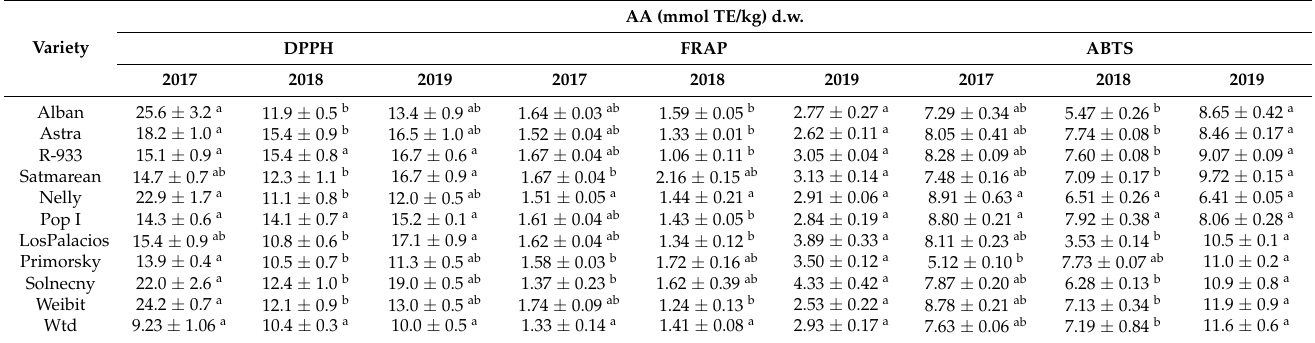
The values represent the means of four repetitions ± standard deviation. Small letters (a, b) show statisti- cally significant differences ( p < 0.05) between years (2017/2018/2019) for each variety, concerning the method (DPPH, FRAP and ABTS, respectively) as examined by multiple pairwise comparisons with a Kruskal–Wallis test. AA—antioxidant activity expressed as millimoles of Trolox equivalents (TE) per kilogram of dry weight. Antioxidant properties were determined spectrophotometrically by different methods using radicals 2,2-diphenyl- 1-picrylhydrazyl (DPPH), 2,2 (cid:48) -azinobis-(3-ethylbenzothiazoline-6-sulfonic acid) (ABTS) and the ferric-reducing antioxidant power